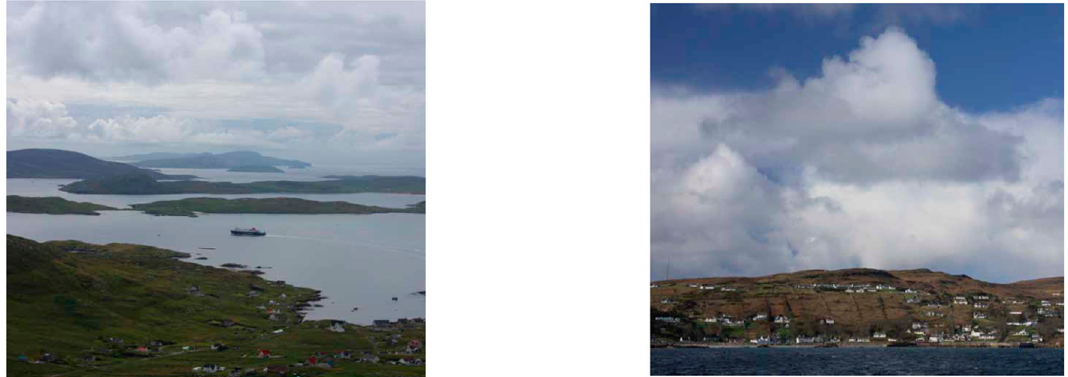
Figure 9. Photographs by Stephen Hurrel, Belonging to the Sea, double spread page, p4 e-book. Image used with permission form the artist.